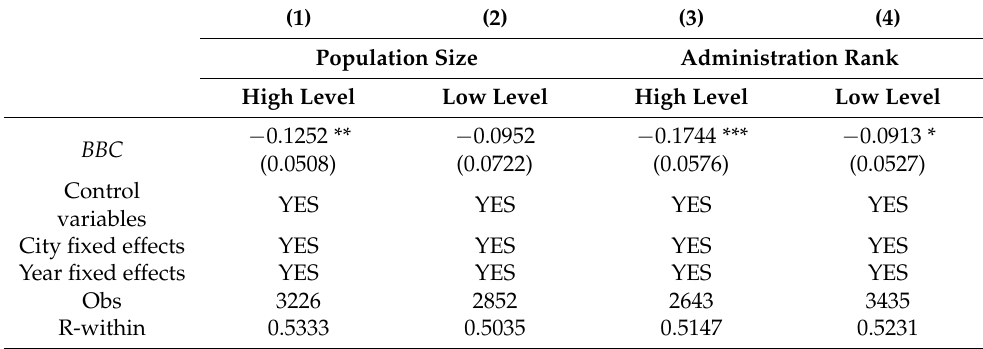
Table 8. Population size and administration